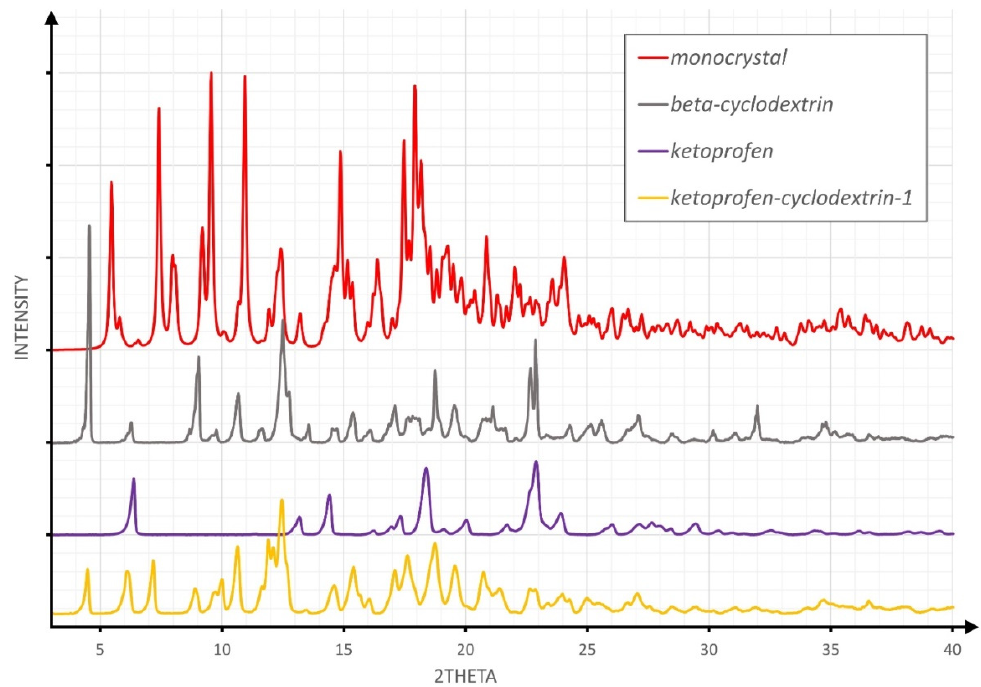
Figure 2. The comparison of XRPD patterns for the product of the co-precipitation experiment.